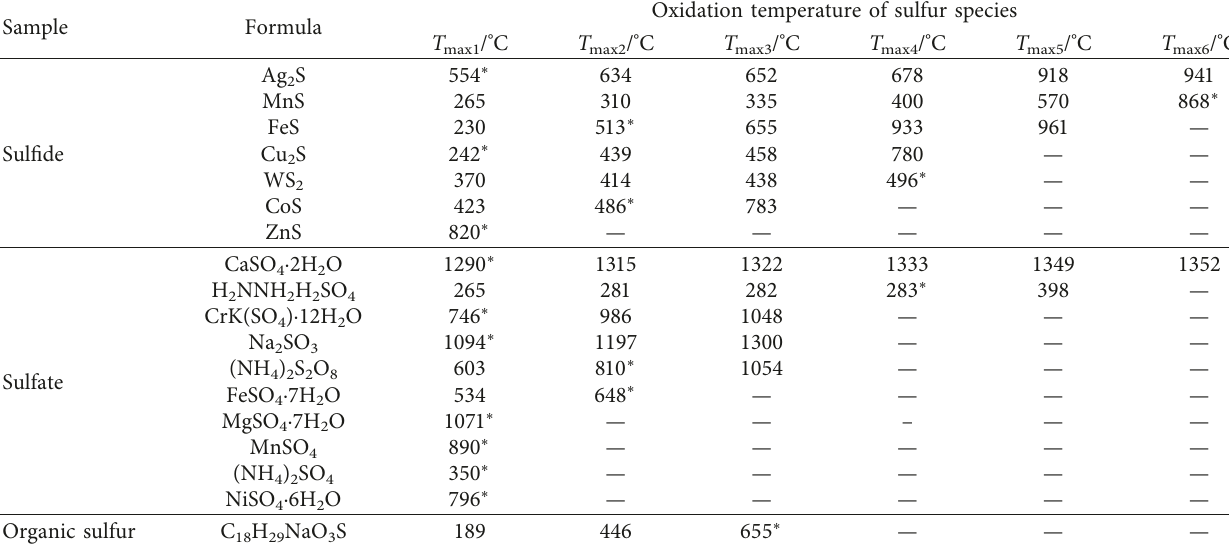
The symbol ‘—’ indicates no peaks appear at this